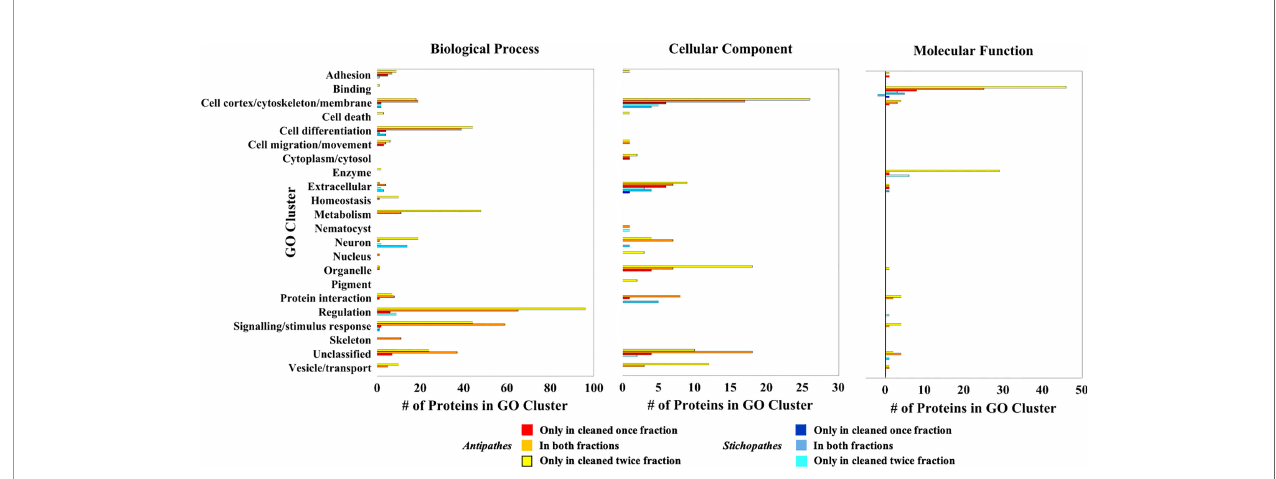
FIGURE 3 | Clustered skeletal proteins with enriched GO terms relative to each species ’ transcriptome. Bars greater than zero are the number of proteins with over- enriched GO terms in the skeletal proteomes whereas those less than zero have under-enriched GO terms. Note the different ranges in the numbers of proteins in each GO